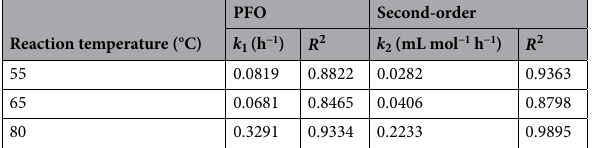
Table 3. Reaction temperatures, rate constants and R 2 values of oleic acid esterification over 6TsOH-MBC